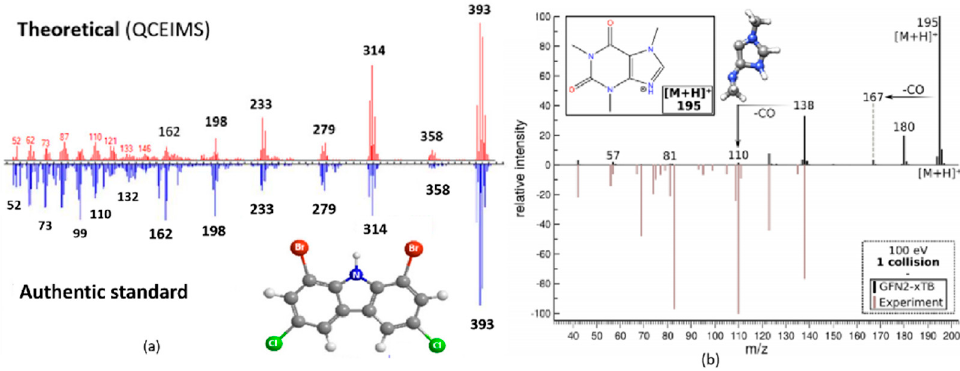
Figure 7. ( a ) EI mass spectrum calculated by QCEIMS and experimental EI mass spectrum of 3,6-dichloro-1,8-dibromo-carbazole. Reproduced from Ref. [110]. Copyright 2021 American Chemical Society. ( b ) calculated spectrum and 40 eV literature spectrum of the most populated caffeine protomer at 600 K, single collision at 100 eV in the laboratory frame. Reprinted from Ref. [111]. Copyright 2021 American Chemical Society.